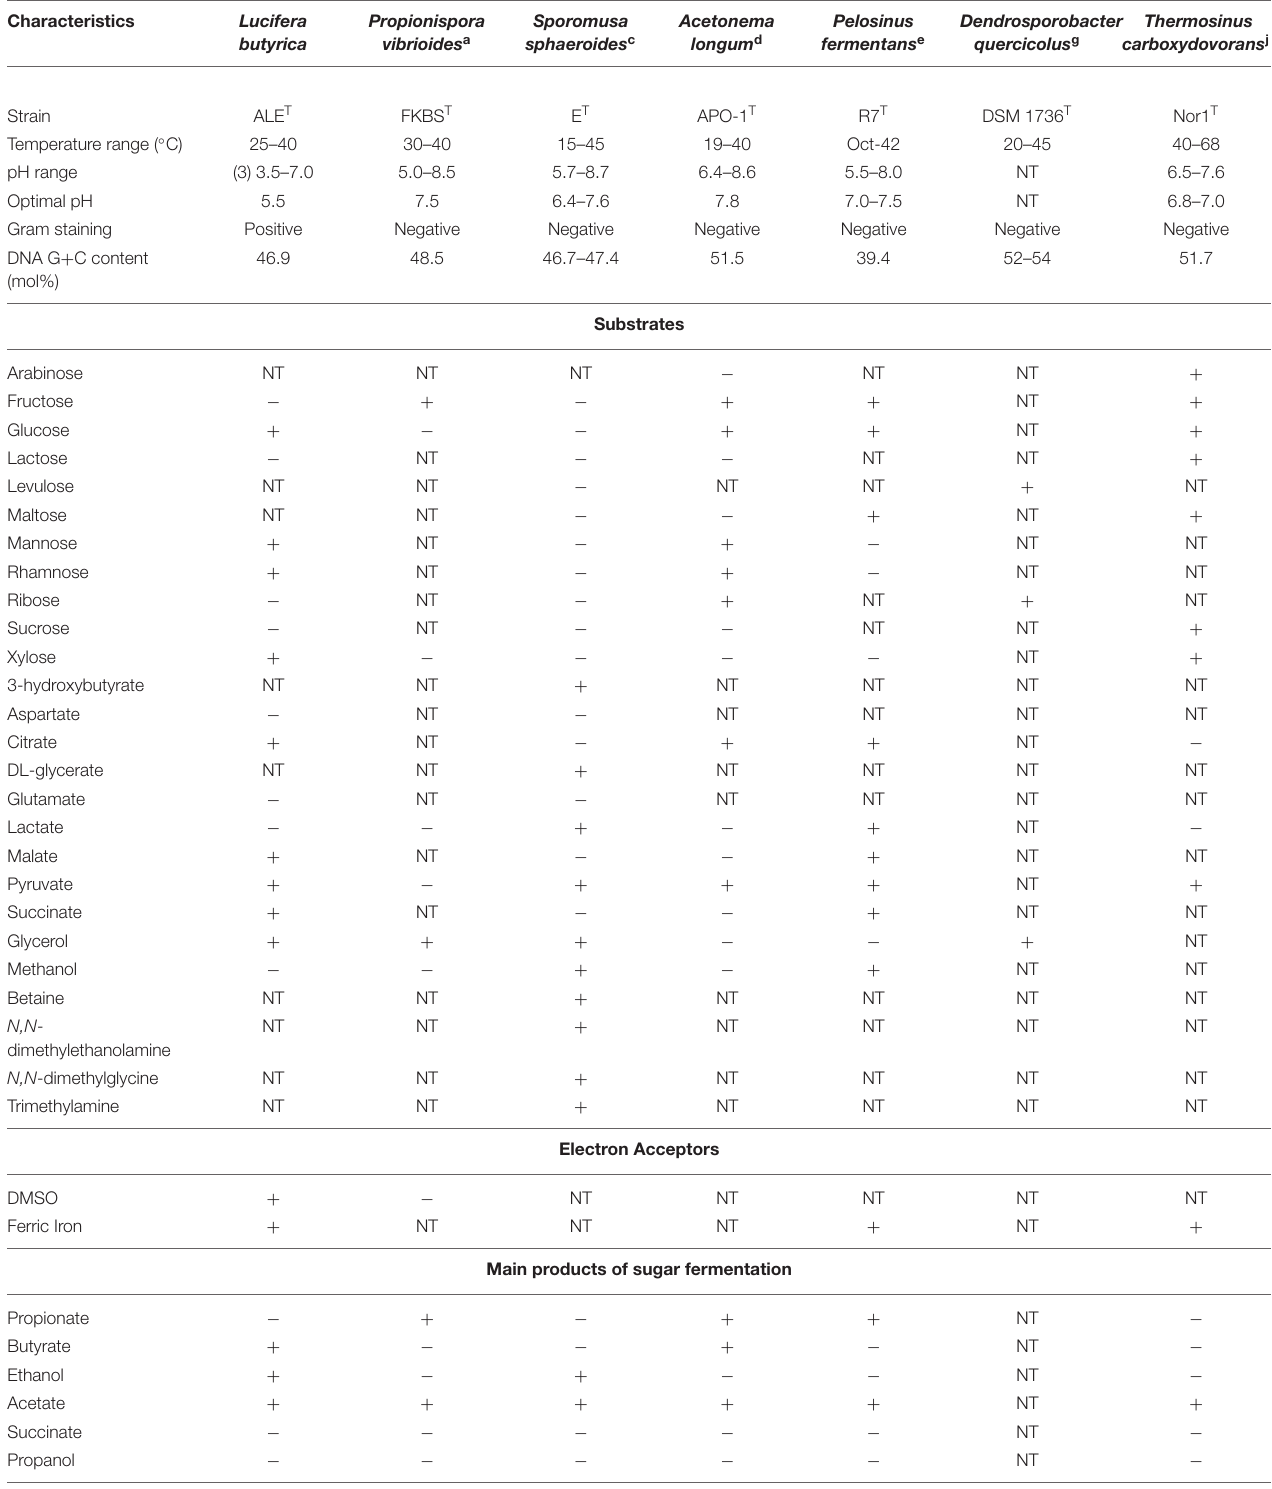
TABLE 1 | Differential characteristics between strain ALE T and its closest relatives of the Sporomusaceae family, selected combining 16S rRNA gene similarity, and phylogenetic reconstructions based on 16S rRNA gene and core genes in the genome.